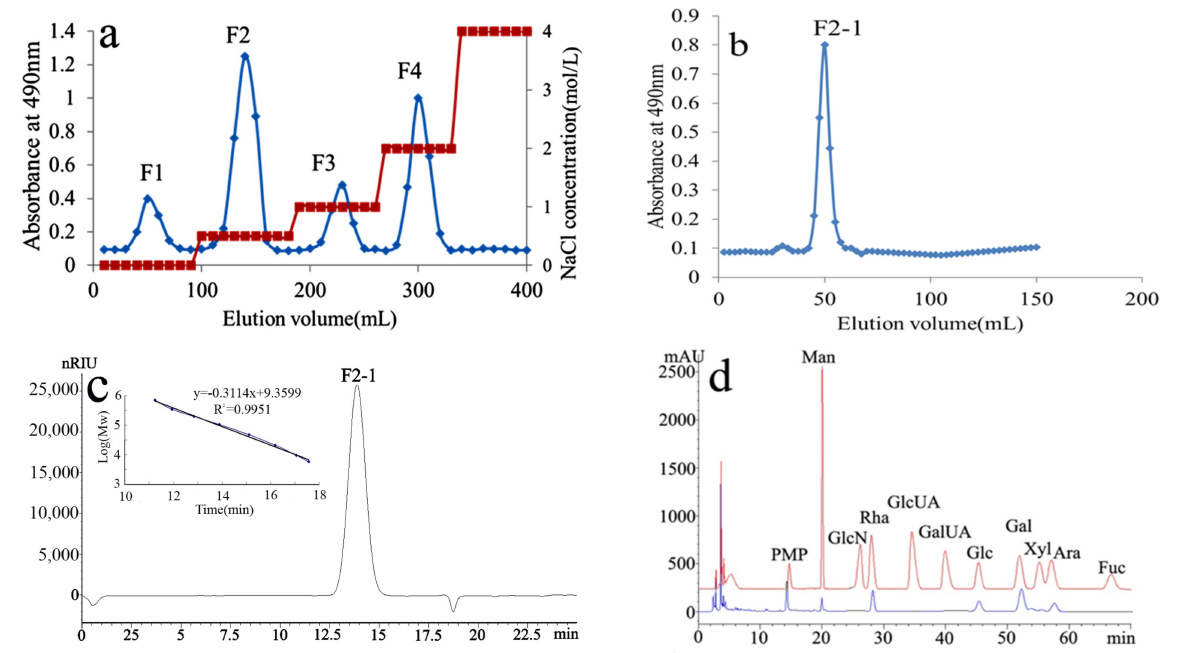
Figure 1. Purification, HPGPC, and HPLC chromatogram of the polysaccharide, F2-1, extracted from the green seaweed Codium isthmocladum . ( a ) Anion exchange chromatography using a Q Sepharose Fast Flow column was used to isolate the crude polysaccharide; ( b ) F2-1 was obtained using gel permeation chromatography of superdex 75; ( c ) HPGPC chromatogram of F2-1 using a TSKgel G3000PWXL column and standard curve of molecular weights; ( d ) monosaccharide composition of F2-1.